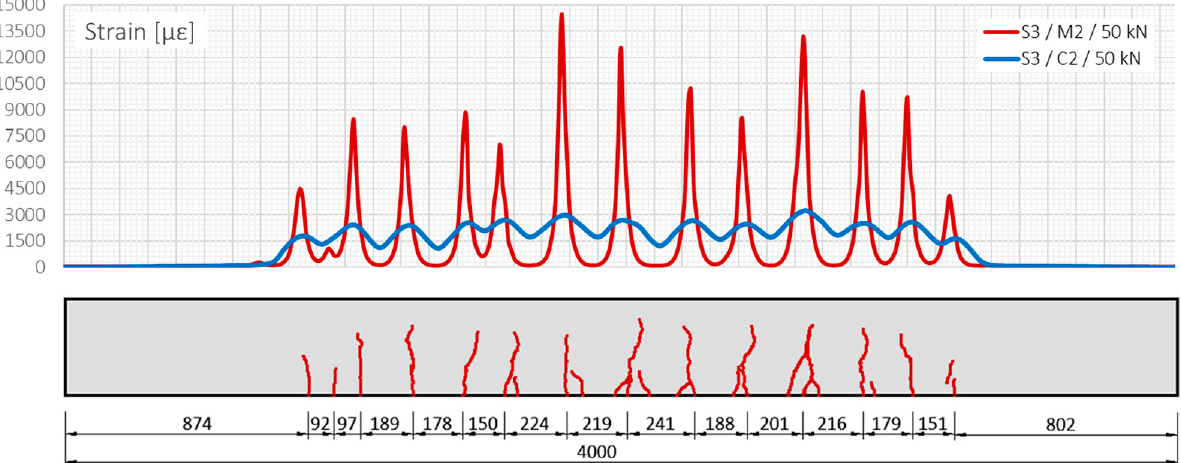
Figure 16. Strain profiles over length measured by monolithic sensor M2 and layered cable C2 (beam S3, load step no. 26, force = 50 kN).